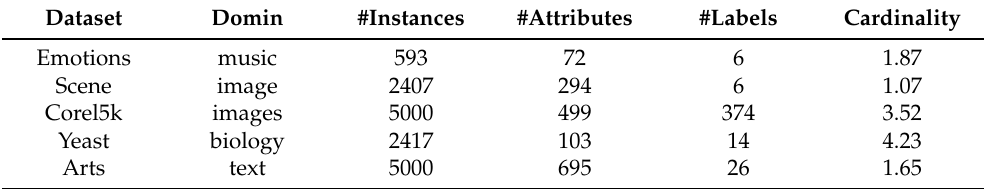
Table 1. Data statistics (“#instances” represents the total amount of instances, “#Attributes” indicates the number of features, including both the numeric and nominal features, “#Labels” is the number of class labels, and “Cardinality” means the average number of labels per